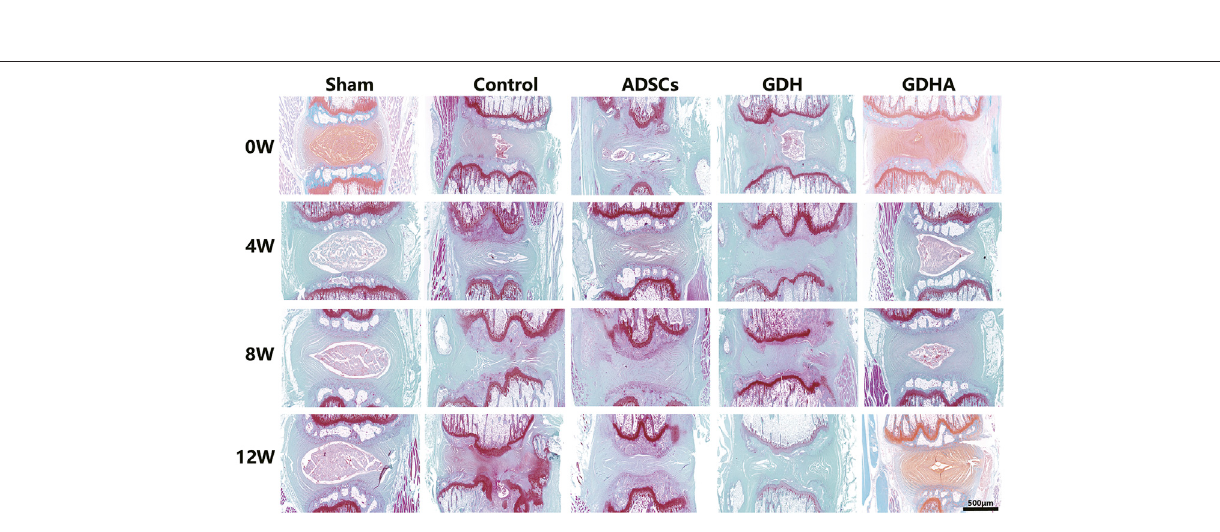
Frontiers in Bioengineering and Biotechnology |